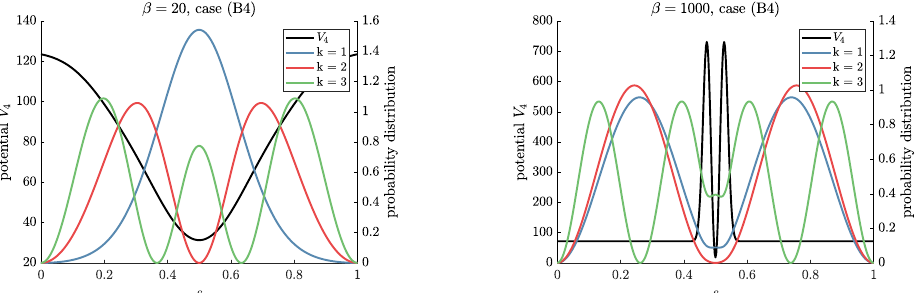
Figure A6. The probability distributions for the full equation (case A4) for β = 20 and β =